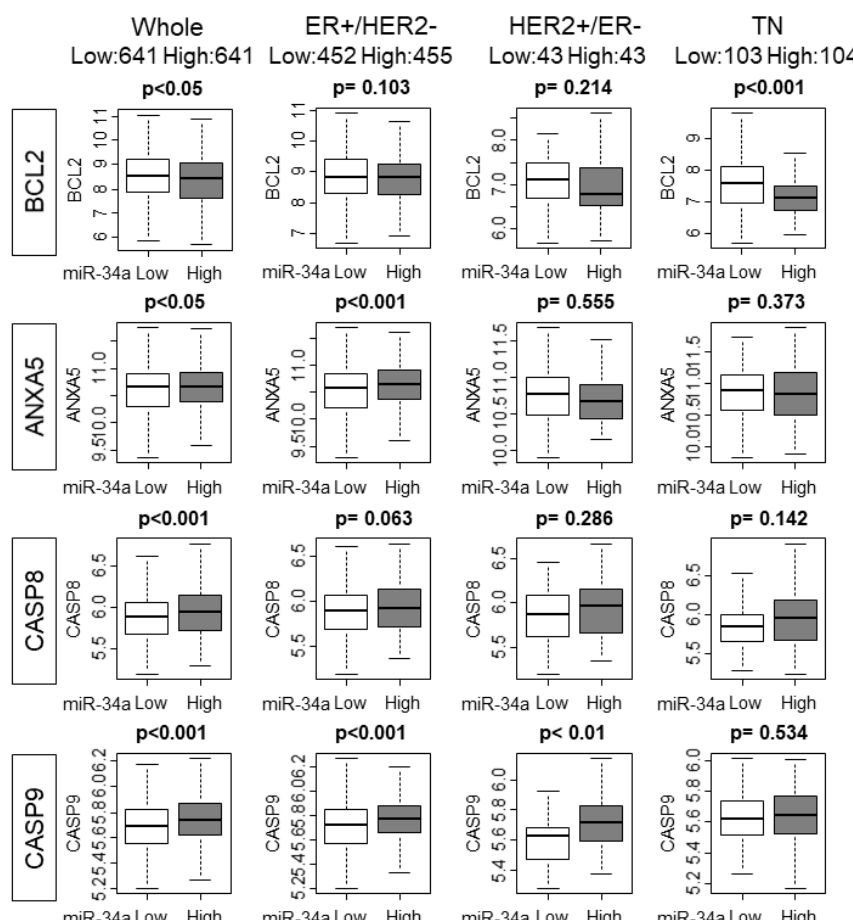
Figure 4. The association of High MiR-34a expression with the expression of apoptosis-related genes in the whole cohort and ER+/HER2 − , HER2+/ER − , and triple-negative (TN) subtypes. 2.5. High MiR-34a Expression Tumors Associated with Higher Epithelial – Mesenchymal Transition (EMT) Score